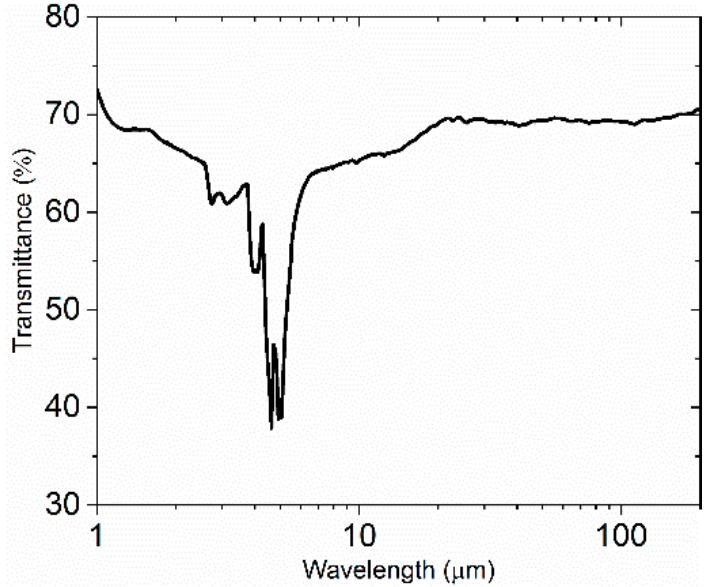
Figure 2. The transmittance of the diamond window.